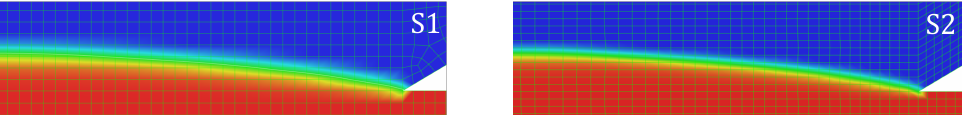
Figure 5. Details of the interface phase contours; the difference between the two simulations S1 and S2, respectively. The interface thickness ( φ ) is the difference between the volume fractions, α = 0.1 and α = 0.9, and for S1 φ S 1 = 19.3 µ m, while for S2, φ S 2 = 12.8 µ